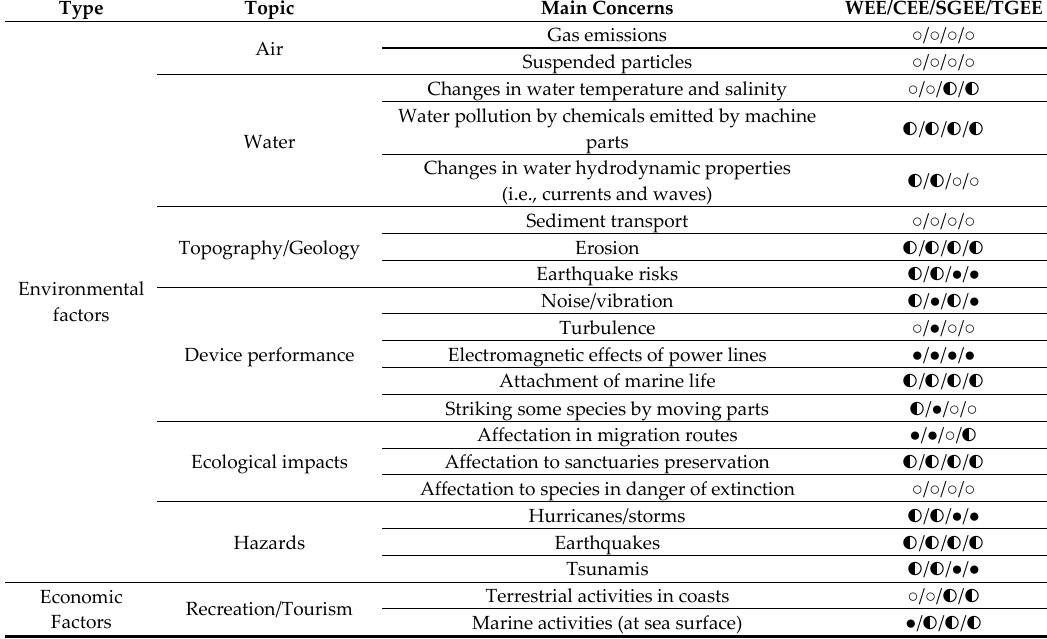
Table 2. Main environmental, economic, and social factors to be considered in ocean energy extraction projects in Mexico, for wave, current, salinity gradient, and thermal energies.